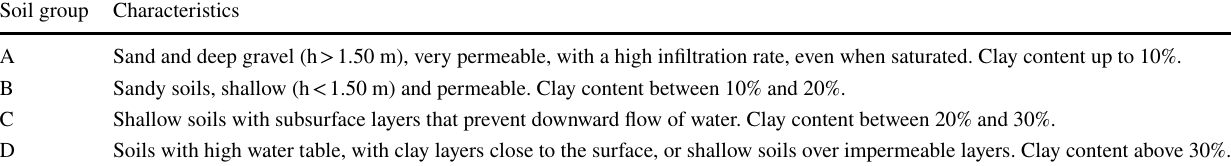
Table 2 Values of CN for vegetated areas. Adapted from USDA